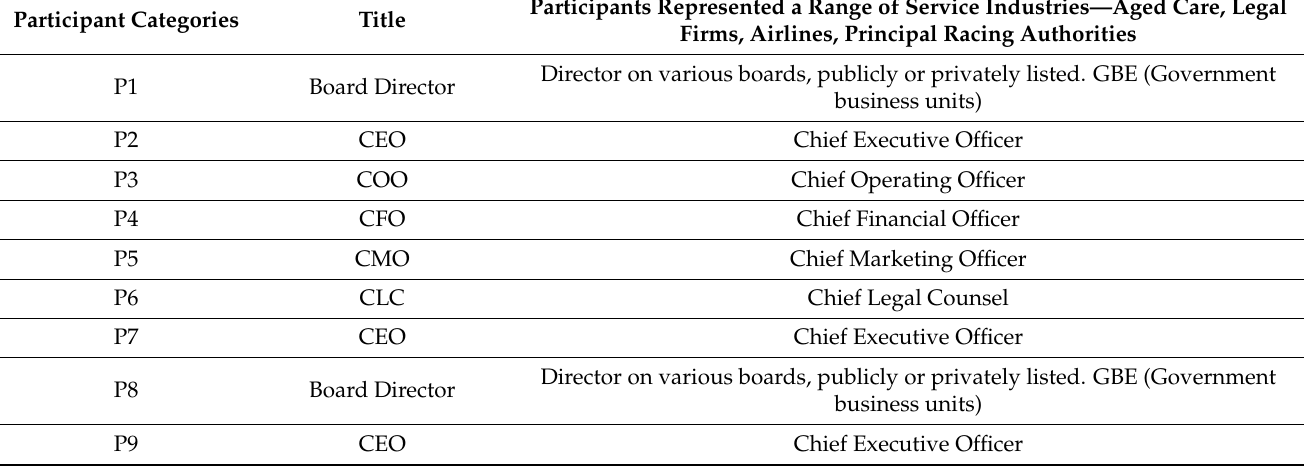
Table 1. Legend of